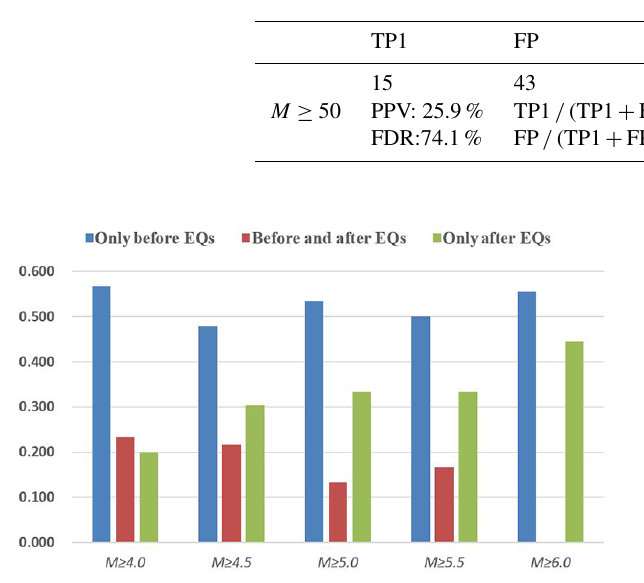
Figure 6. Distribution of TIR anomalies with respect to earthquake occurrences for different classes of magnitude.